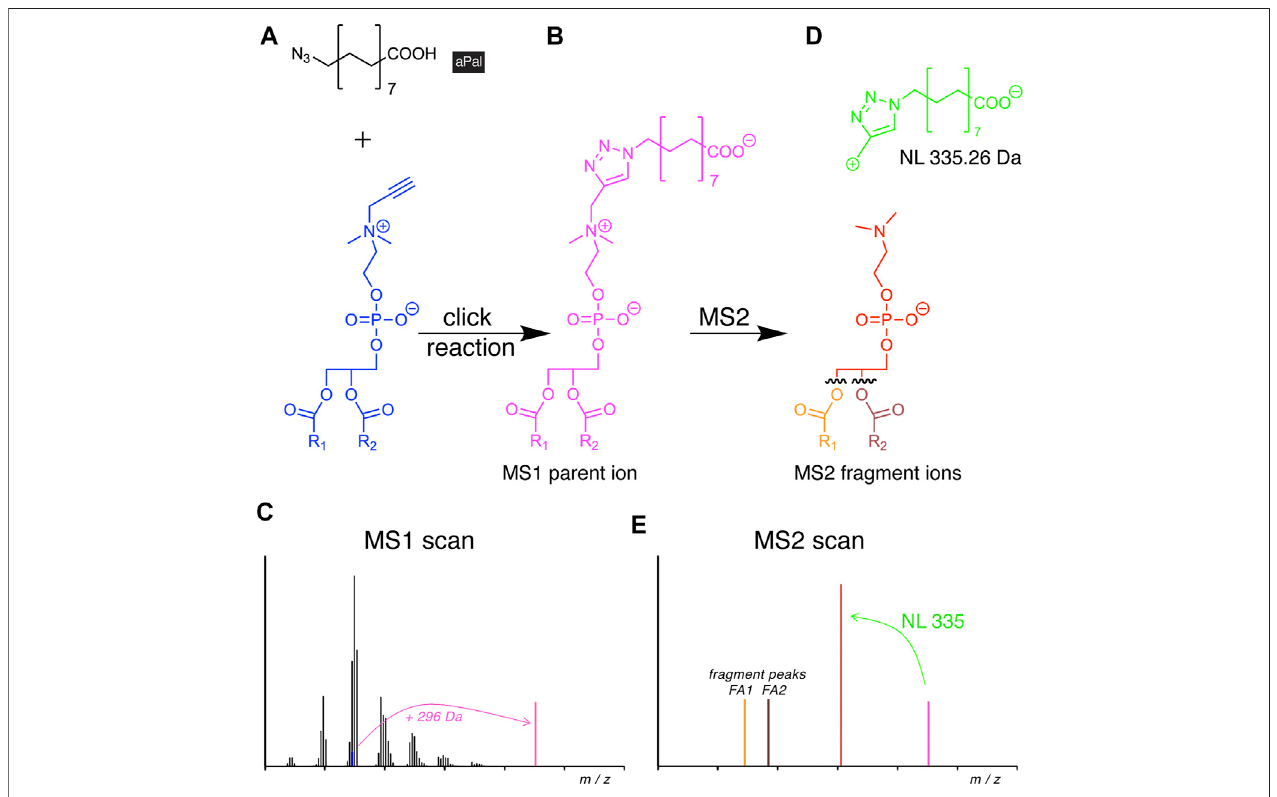
FIGURE 6 | Scheme of alkyne lipid detection by negative-mode DIMS using azidopalmitate (aPal). The aPal reporter (A) is click-reacted with a phosphatidylpropargylcholine (blue) to generate a mass-shifted product (B), discriminating its MS1 ion peak ( C , magenta) from unlabeled phosphatidylcholine species. MS2fragmentation (D) yieldsastereotypicalneutralloss(NL,green)andgeneratesadiagnosticfragmention( E ,red)thatuponfurtherfragmentationnotonlyenablesthe identi fi cation of the lipid analyte, but also of the two FA